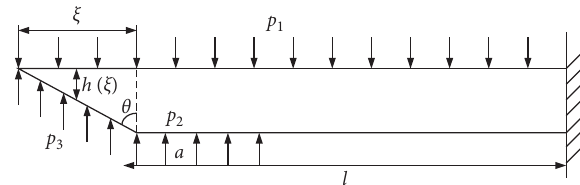
Figure 15: The mechanics model of the reverse direction